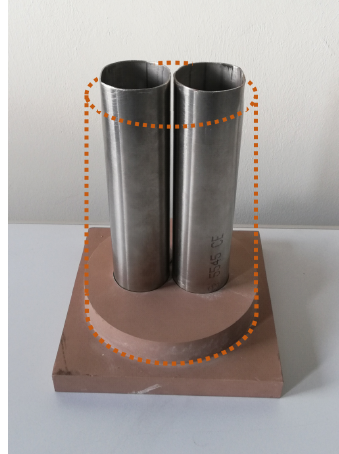
Figure 5. Cylindrical electrodes inserted in the resin base used for the measurement of the electric parameters. The dashed orange lines represent the shape of the PVC tube used to create the container using the resin base as